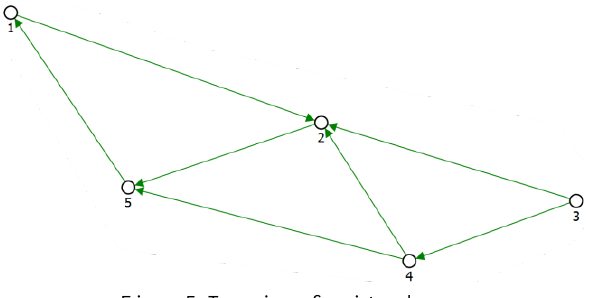
Figure 5. Top view of registered